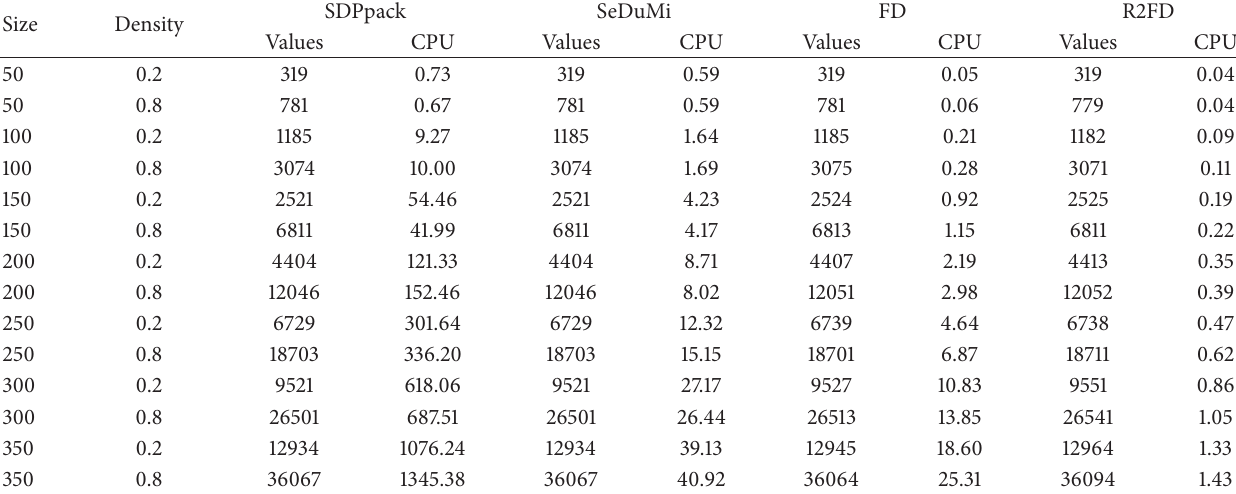
Table 1: Comparison results for the random graphs.